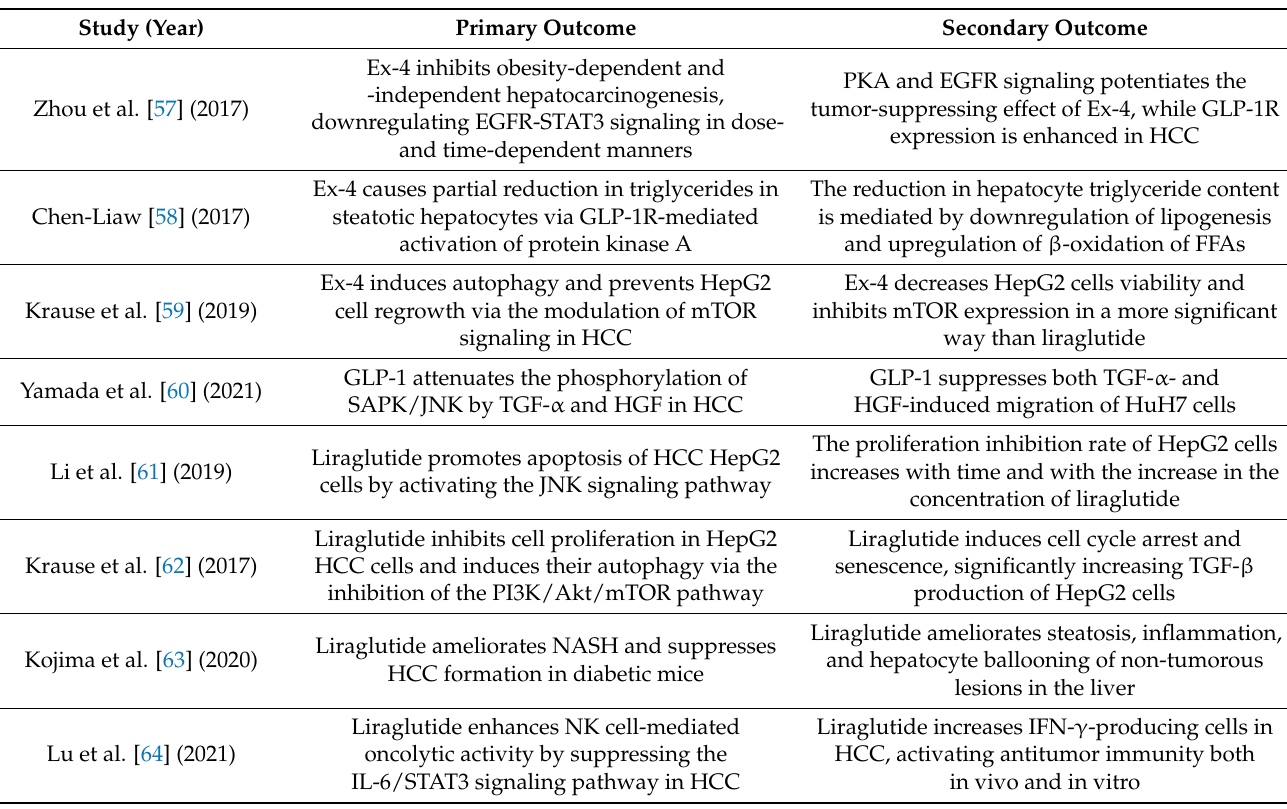
Table 2. Summary of studies evaluating the role of GLP-1RAs in